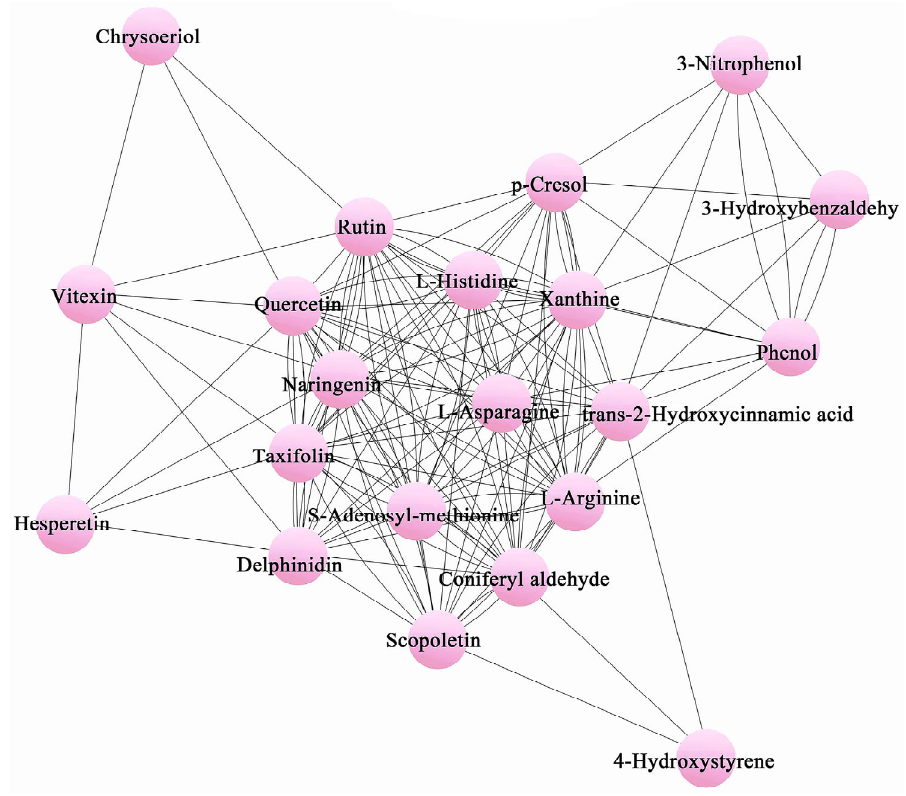
Figure 3. Metabolite network relationship of aromatic substances. Each node represents a metabolite.